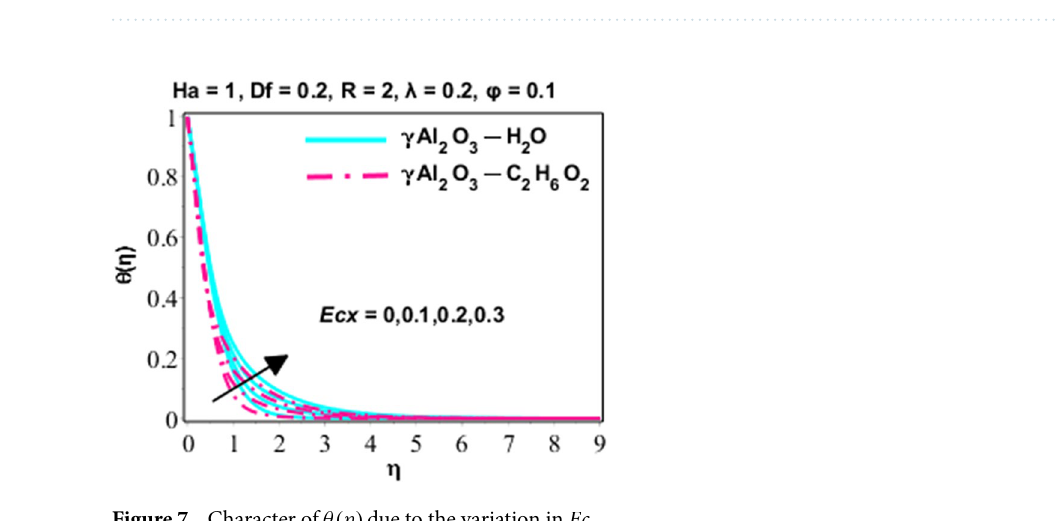
Figure 6. Character of θ(η) due to the variation in R .